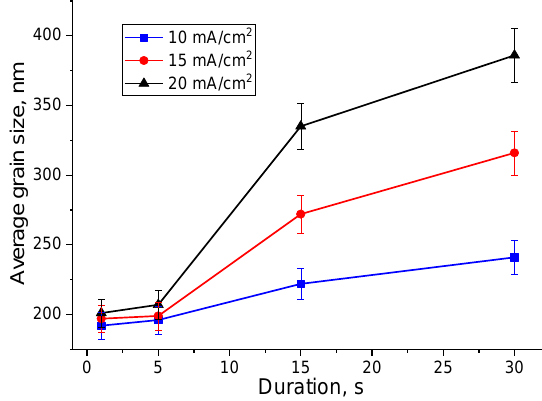
Figure 8. The average grain size of electrodeposited films versus deposition duration.